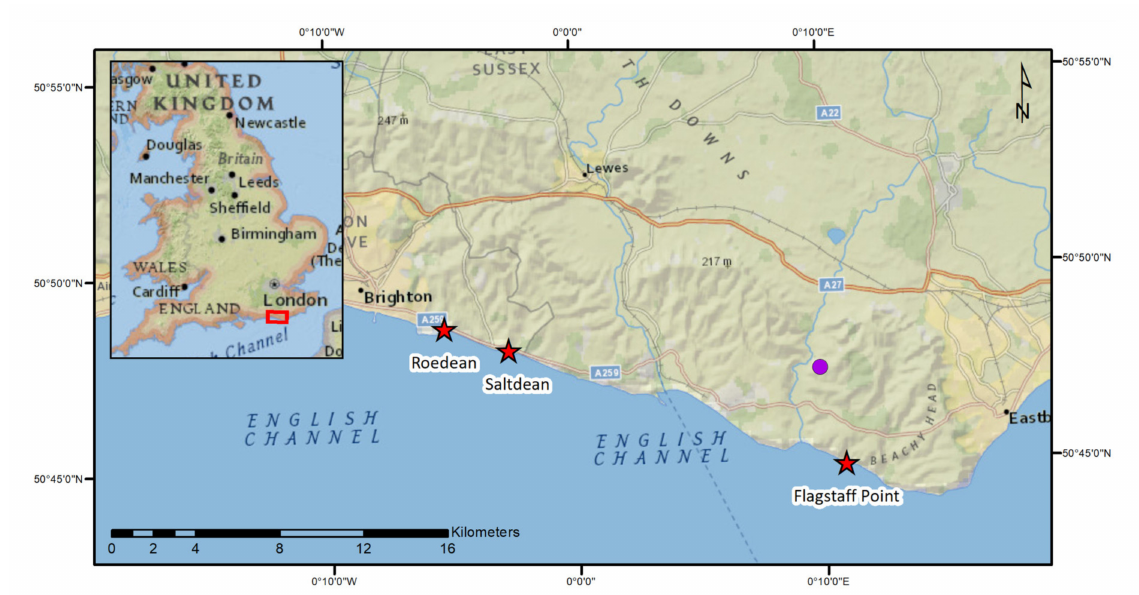
Figure 1. Map of the study area. Location of research sites marked with red stars. Purple circle represents the location of the reference point that has been used for PS processing in this study. Overlain onto ArcGIS Online National Geographic World Map (Sources: National Geographic, Esri, Garmin, HERE, UNEP-WCMC, NASA, ESA, METI, NRCAN, GEBCO, NOAA, increment P